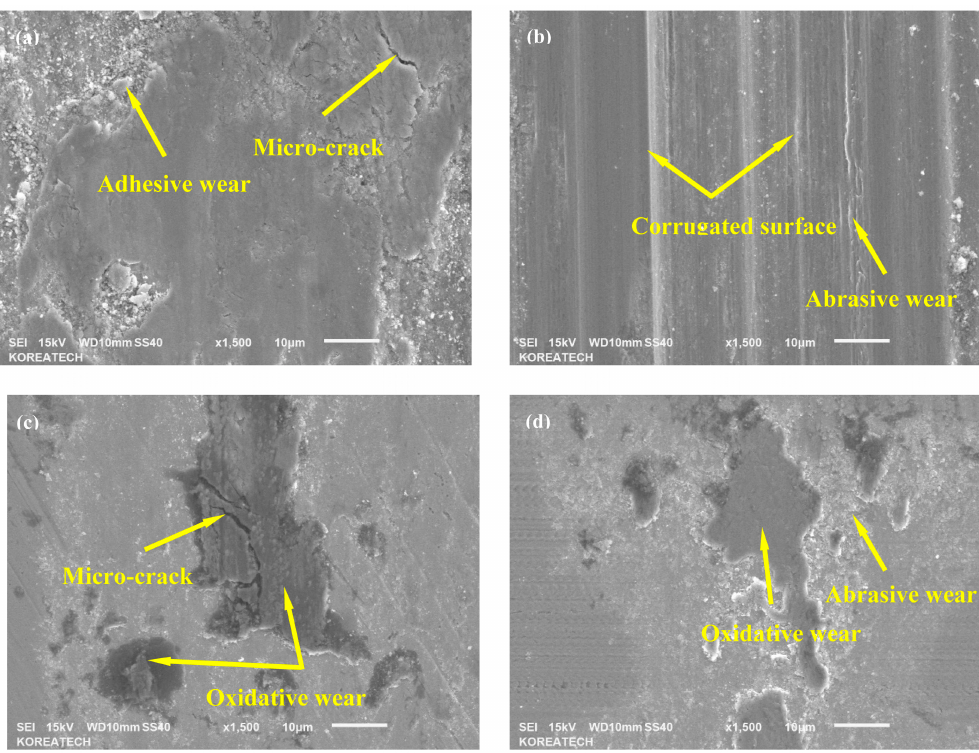
Figure 9. High-magnification SEM images of the bulk ( a , b ) and 3D-printed ( c , d ) AISI H13 tool steel specimens before and after UNSM treatment.